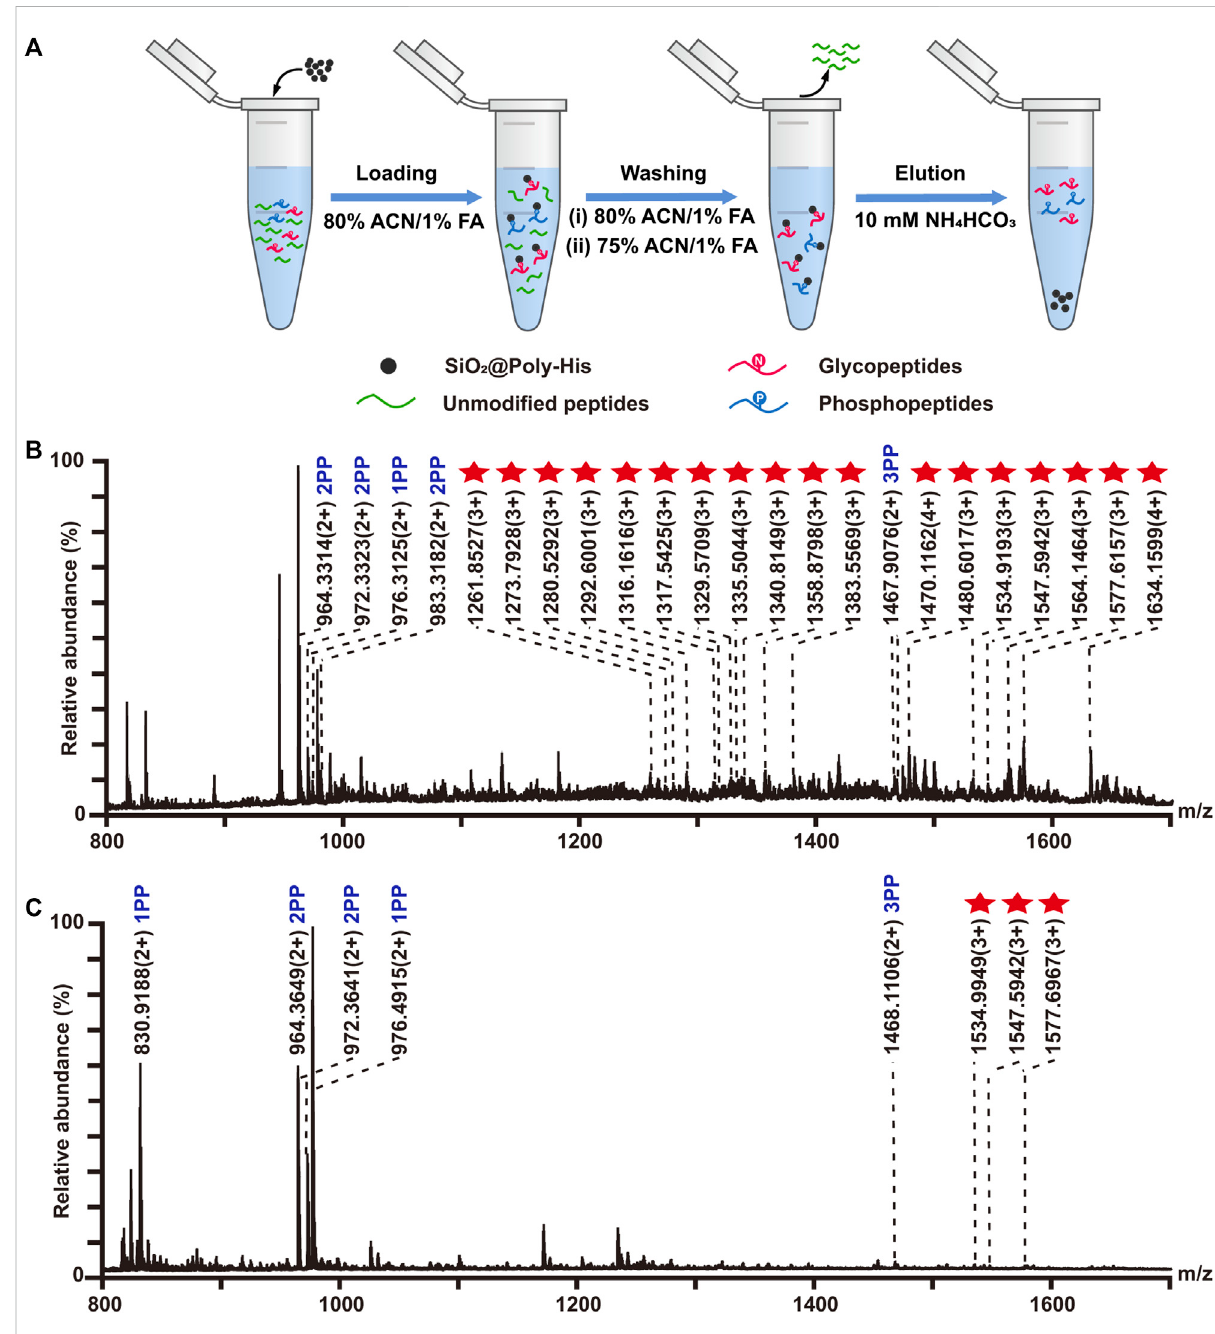
FIGURE 4 Simultaneous enrichment of glycopeptides and phosphopeptides with SiO 2 @Poly-His microspheres and commercial TiO 2 materials. (A) Work fl ow for the simultaneous enrichment of glycopeptides and phosphopeptides with SiO 2 @Poly-His microspheres; (B) Mass spectrum of the mixture of α -casein, bovine fetuin and BSA at molar ratio of 1:0.67:1,000 enriched by SiO 2 @Poly-His microspheres and (C) Mass spectrum of the mixture of α -casein, bovine fetuin and BSA at molar ratio of 1:1:1,000 enriched by TiO 2 . Red star represents glycopeptide; XPP represents phosphopeptide, among which X is the number of phosphate groups in a